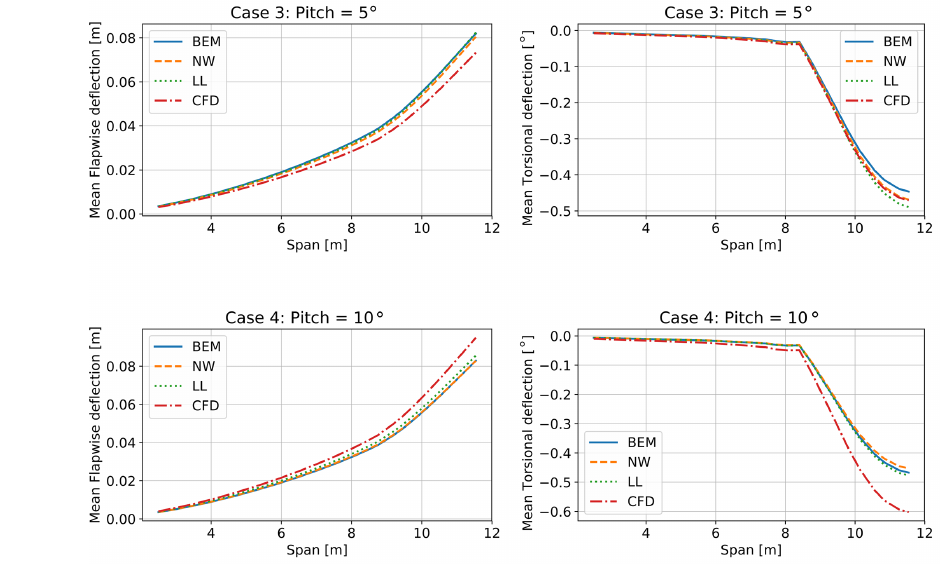
Figure 14. Comparison of mean deflections for case 3 and case 4. The torsional deflection is given about the pitch